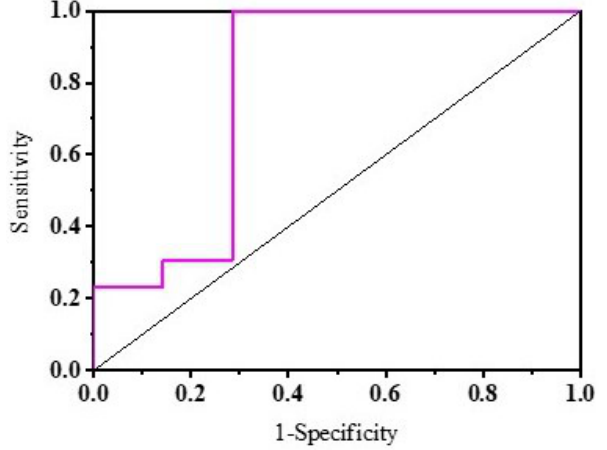
Figure 9. ROC curve for k-means clustering with RR as dependent